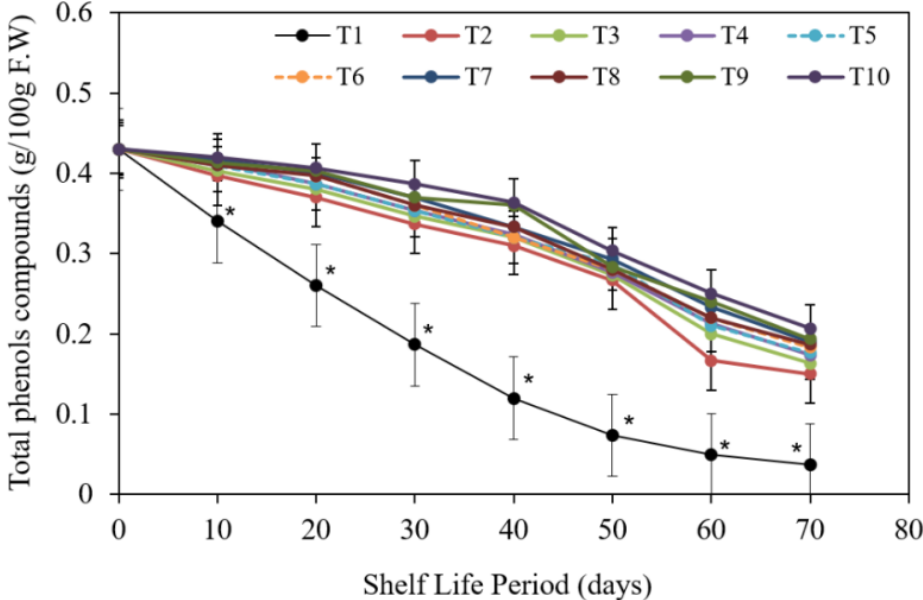
Figure 13. The impact of pre-harvest chitosan, chitosan nanoparticle, and CaCl 2 foliar spray treatments on total phenols compounds of Barhi date fruits under cold storing for 70 d. Note that * sign denotes the significant differences between the control and edible coatings treatments, and T1, T2, T3, T4, T5, T6, T7, T8, T9, T10 are water (control), 1 g/L chitosan, 2 g/L chitosan, 3 g/L chitosan, 1 g/L chitosan nanoparticles, 2 g/L chitosan nanoparticles, and 3 g/L chitosan nanoparticles treatments, respectively.